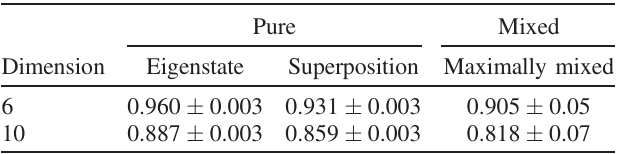
TABLE I. Experimental fidelities of pure and mixed recon- structed states in dimensions 6 and 10. The coincidence counts are 5 and 3 kHz for dimension 6 and dimension 10, respectively. Pure Mixed Dimension Eigenstate Superposition Maximally mixed 6 0 . 960 (cid:3) 0 . 003 0 . 931 (cid:3) 0 .